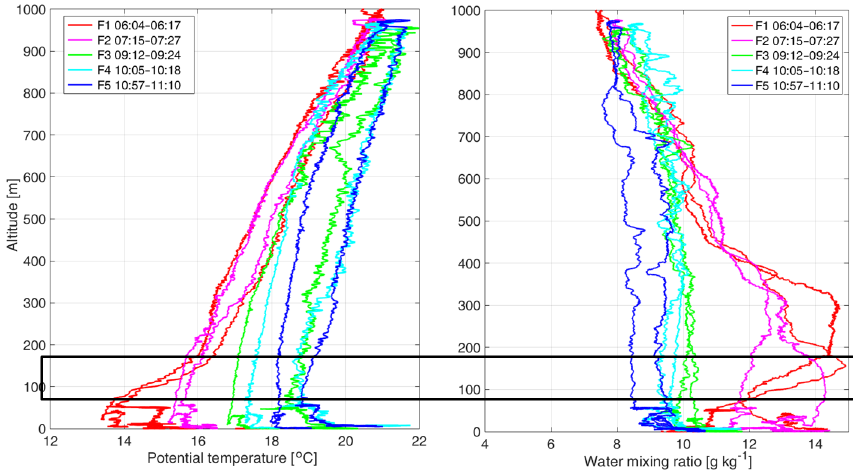
Figure 8. Profiles of potential temperature and water vapour mixing ratio obtained on 5 September 2018. The times of the three flights are given in UTC. The horizontal box represents the height interval of the temperature inversion, which is also visible in the large changes of the water vapour mixing ratio.